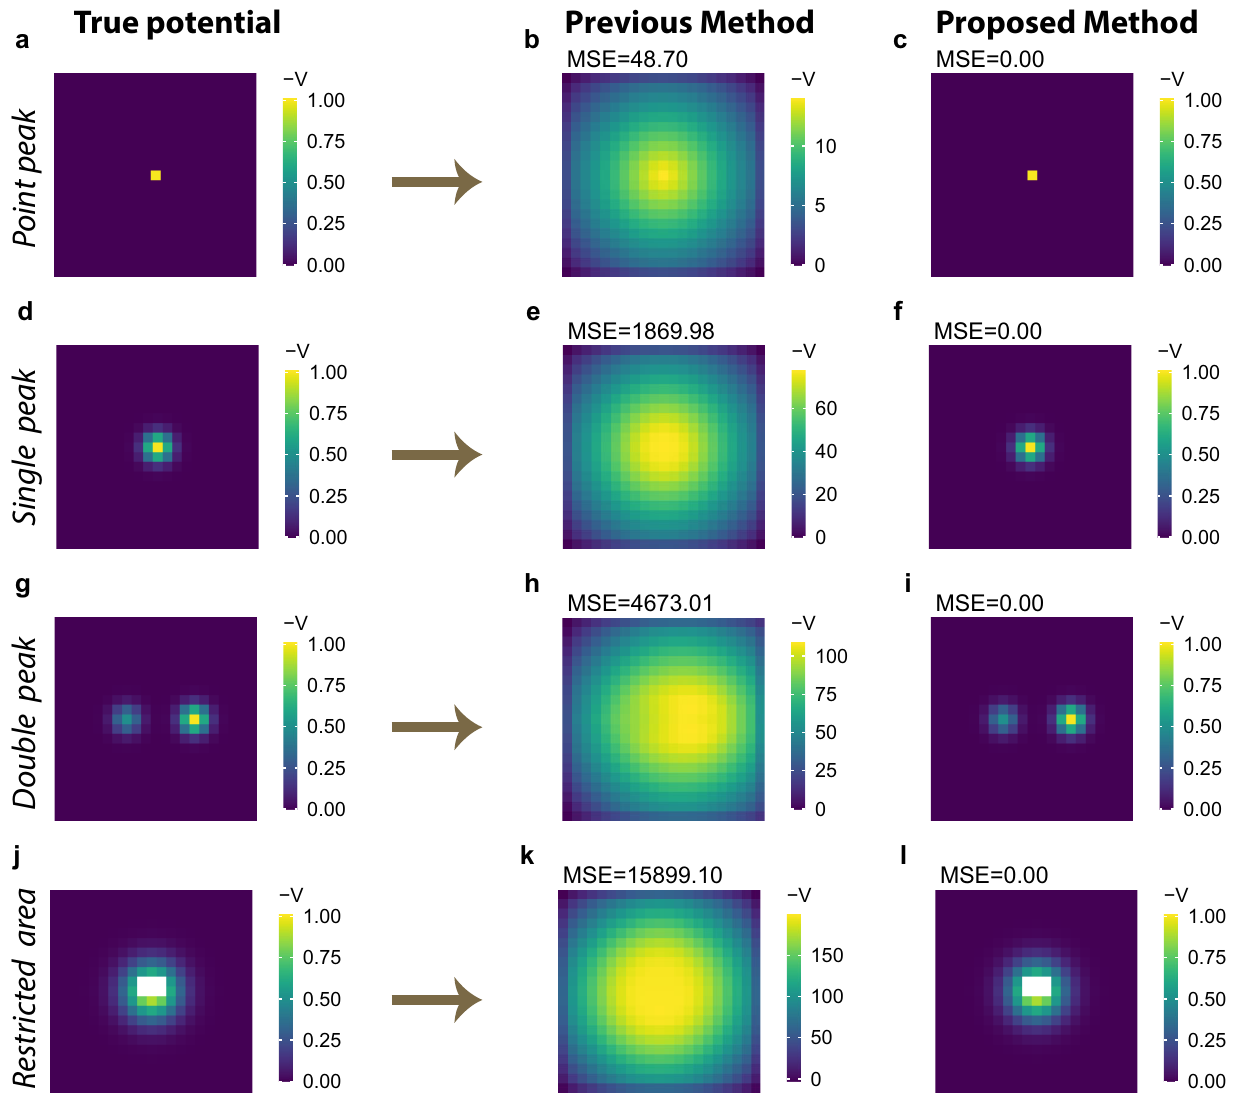
Figure 2. Potential identification for conceptual situations. ( a–c ) point peak situation represents an artificial monocentric city. There is an attractive location at the centre, to which people move from all other locations ( a ). Given an OD matrix generated by this situation, the potential estimated by the previous method 1 is shown in panel ( b ) and that by the proposed method is shown in panel ( c ). ( d-f ) single peak situation is similar to the point peak situation, but the central place has some spatial extents ( d ). The potential is estimated by the previous method ( e ) and the proposed method ( f ), respectively. ( g-i ) double peak situation represents a polycentric city, in which there are two attractive places ( g ). The potential is estimated by the previous method ( h ) and the proposed method ( i ), respectively. ( j-l ) In the restricted area situation ( j ), the potentials at some locations (white cell) are not available ( NA ), because they are, for example, a restricted area or a lake. These NA locations cannot be the origin or destination of flow. The potential is estimated by the previous method ( k ) and the proposed method ( l ),